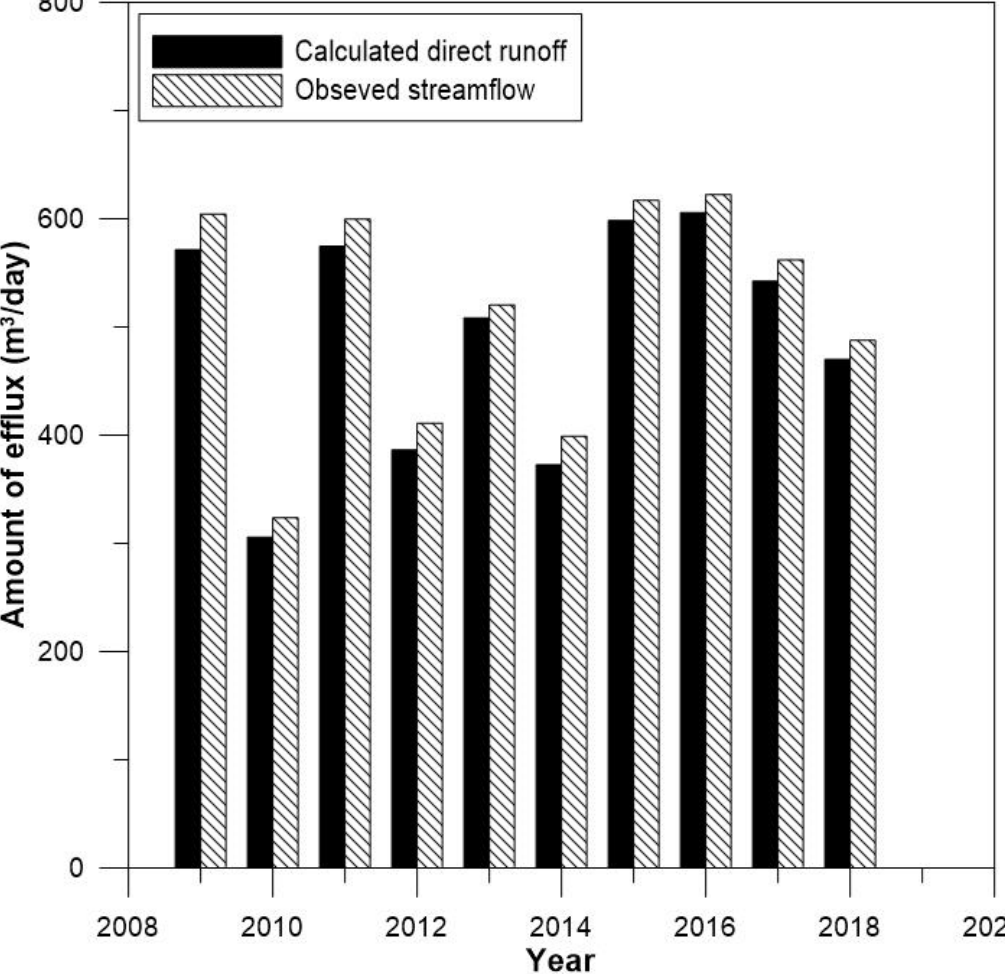
Figure 7. The observed streamflow and calculated direct runoff during 2009 – 2018.